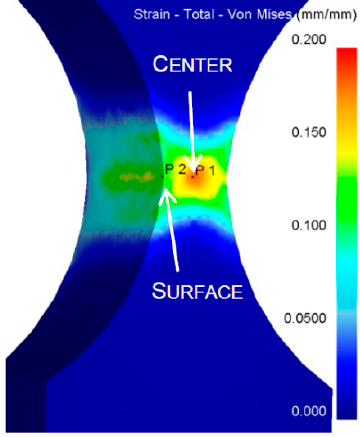
Table 4. Critical damage values identified by simulation. Specimen Type